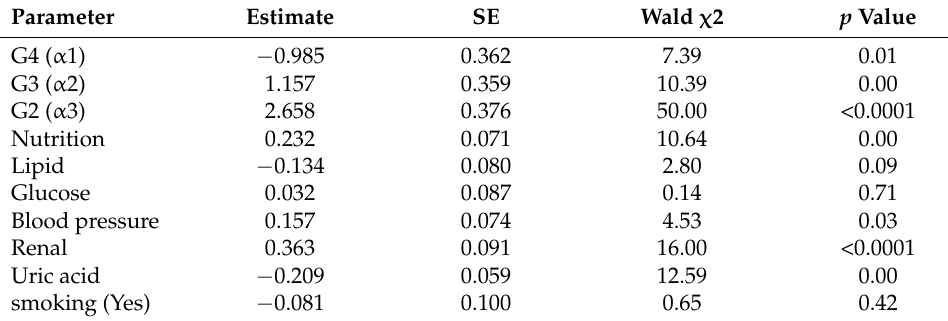
Table 6. Estimate of the ordinal logistic regression